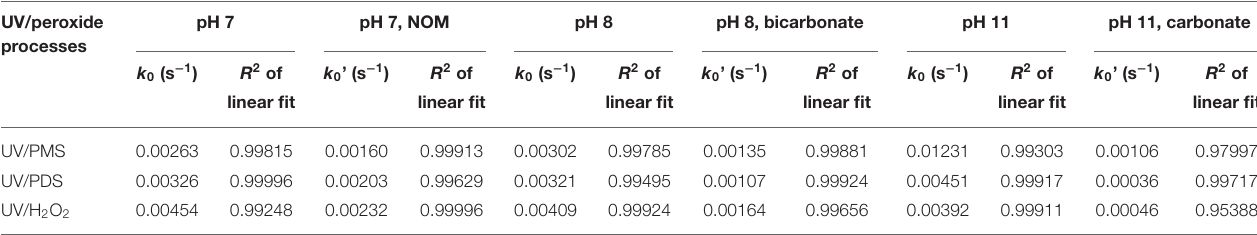
TABLE 1 | Pseudo-first-order rate constant ( k 0 ) of BA degradation in the presence and absence of radical scavengers in UV/peroxides obtained by fitting data of BA removal within 75%.